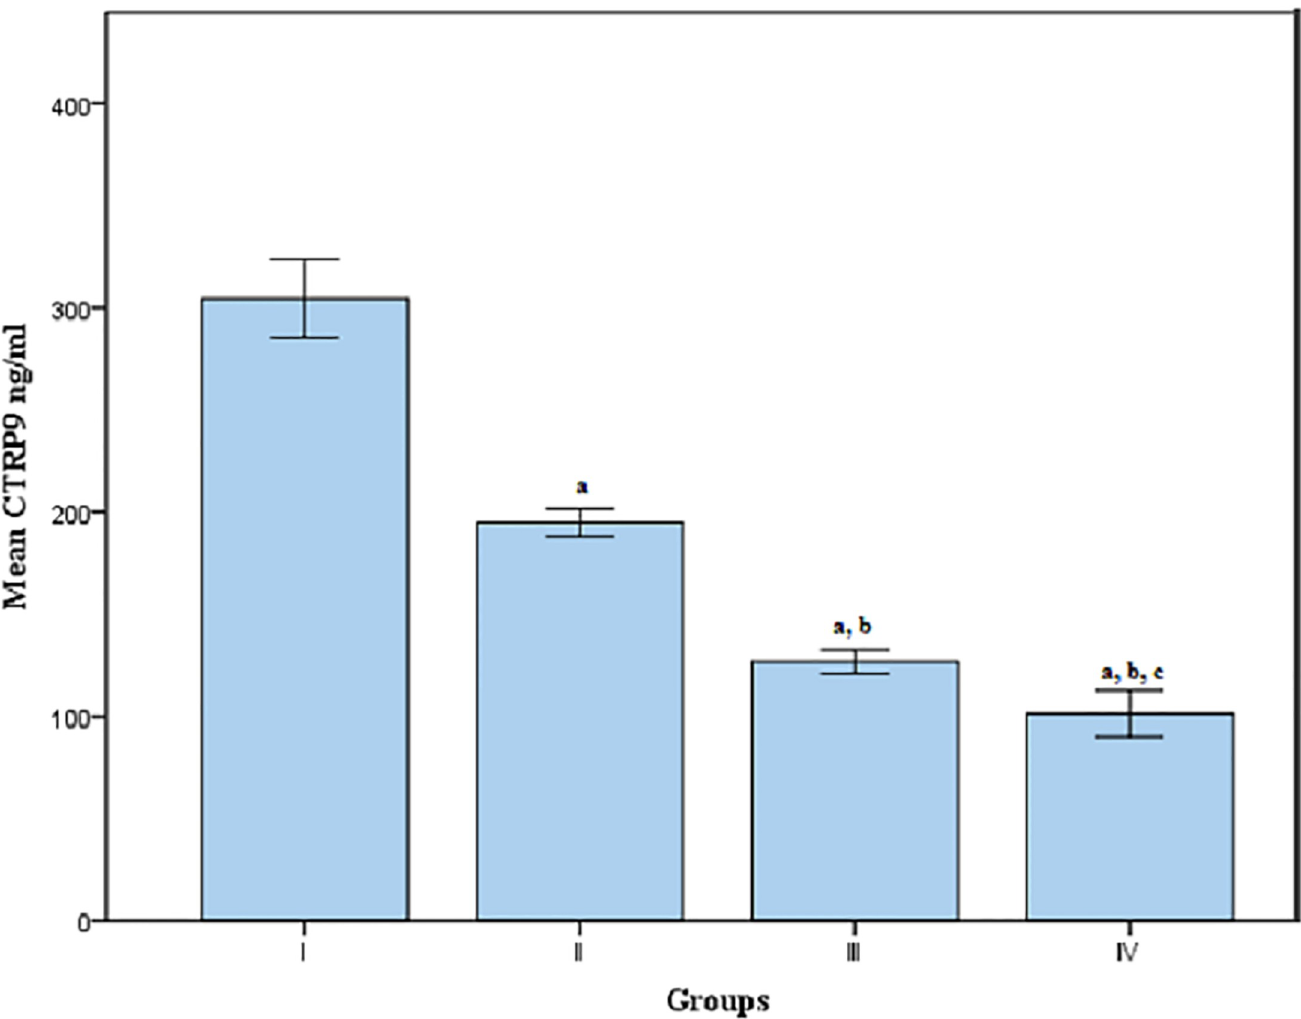
Fig 2. Mean serum CTRP9 levels in groups I, II, III and IV. Group(I):Apparent healthy control, Group(II):Patients with CAD, Group(III):Patients with T2DM, Group(IV):Patients with CAD secondary to T2DM, a: Significantly different from group I at p < 0.05, b: Significantly different from group II at p < 0.05, c: Significantly different from group III at p < 0.05, CTRP9: C1q complement/tumor necrosis factor (TNF)—related protein 9.